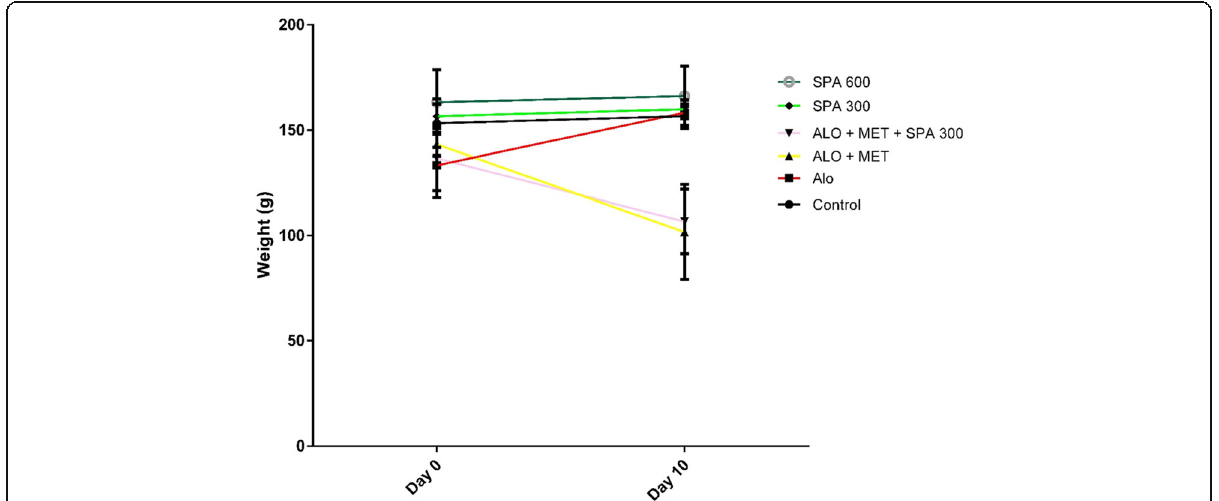
Fig. 1 Effect of methanol extract of S. sparganophora leaves on the bodyweight of alloxan-induced hyperglycemic rats. Results were expressed as mean + standard deviation